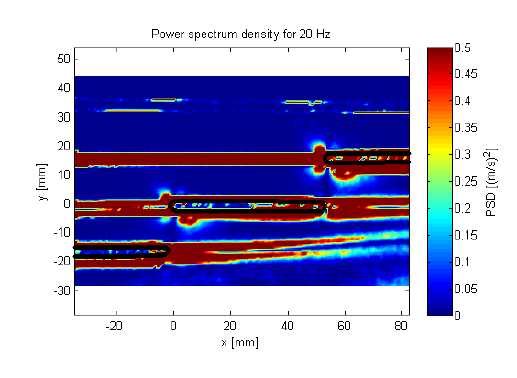
Fig. 6d. PSD scalar map for 20Hz, 40m/s for v-component.